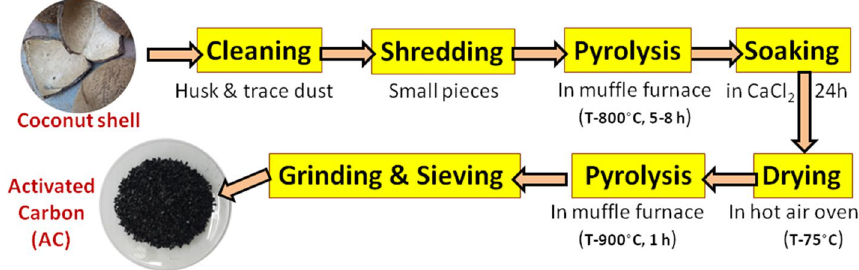
Fig. 1 Schematic for the prepa- ration of AC using coconut